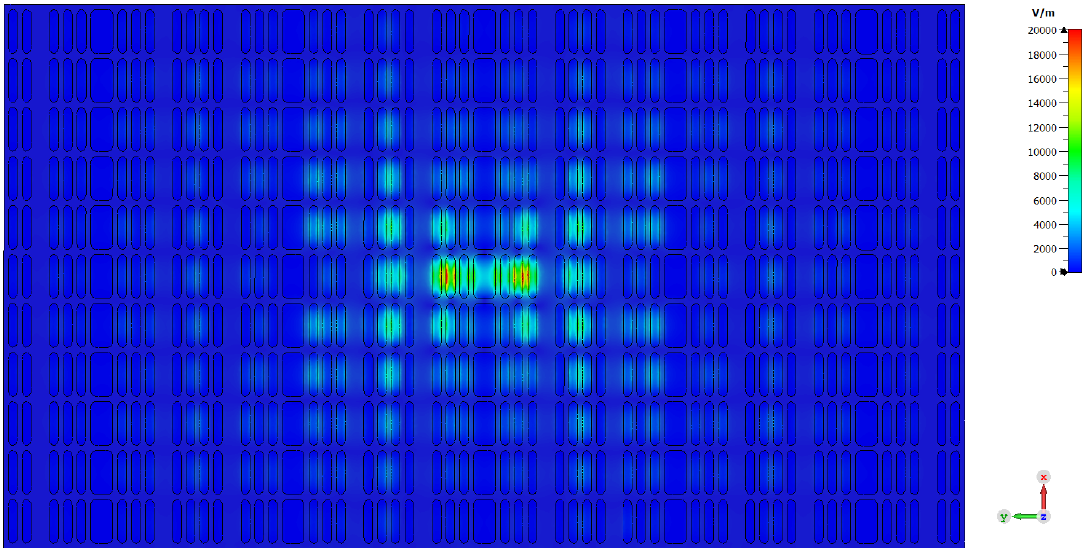
Figure 7. Calculated electric field distribution of the central sub-array when all other sub-arrays are matched in the 11 × 5 array at the design frequency f 0 = 28.0 GHz.